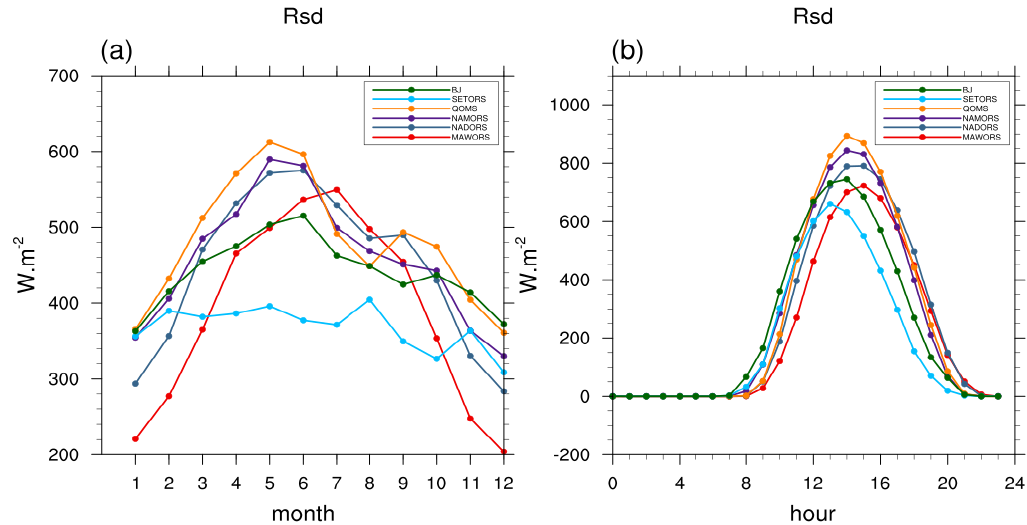
Figure 7. Annual variation of downward shortwave radiation ( a ) and diurnal variation of downward shortwave radiation ( b ) at each station.